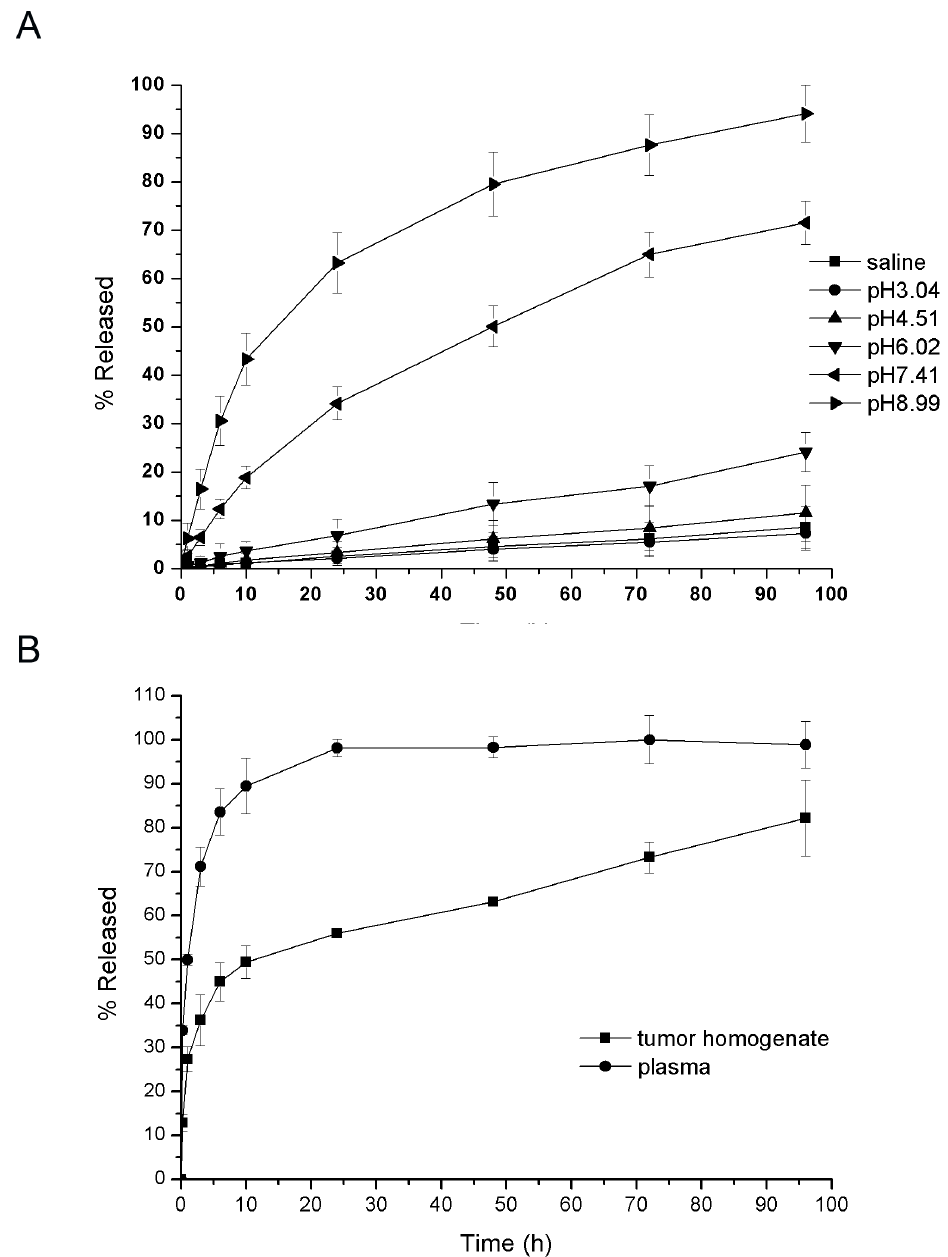
Figure 2. Invitro drug release of 5-FA-PAE. (A) Drug release profiles of 5-FA-PAE in PBS and saline. 100 m l 5-PA-PAE was added to preheated release media (PBS of different pH values or saline) and incubated at 37 u C with stirring. Samples were collected at fixed time intervals, acidified by hydrochloric acid (1 M) and analyzed by HPLC. (B) Drug release profiles of 5-FA-PAE in murine tumor homogenate and plasma. The samples from mouse plasma and tumor homogenate were obtained in duplicate at each time point (100 m l each). For hydrolysis, 100 m l sodium hydroxide (1 M) were added to samples followed by 100 m l hydrochloric acid (1 M). The other group was not subjected to hydrolysis by substituting sodium hydroxide solution with saline and acidifying with 50 m l hydrochloric acid. The differences of 5-FA in the two groups at the same time point was the unreleased 5-FA in each sample. Each value represents the mean 6 SD (n=3).